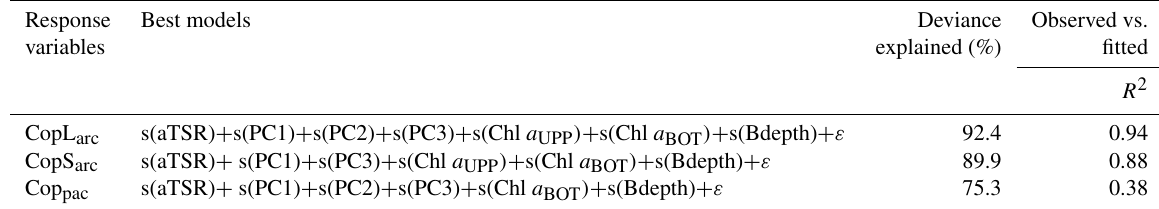
Figure 3. Distribution of main principal component score (PC1–3) in 2007, 2008 and 2013. Coloured circles indicate magnitude of PC. Table 5. Best models of each copepod groups: large Arctic (CopL arc ) , small Arctic (CopS arc ) and Pacific (Cop pac ) copepods.